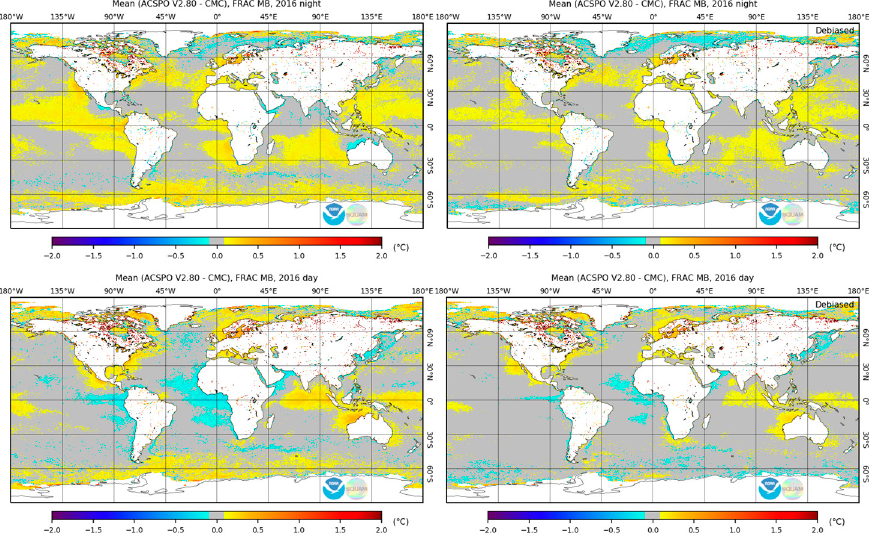
Figure 14. Yearly composite maps of Metop-B ACSPO – L4 CMC SST in 2016. ( Top ) night; ( bottom ) day; ( left ) GR; ( right ) PWR.